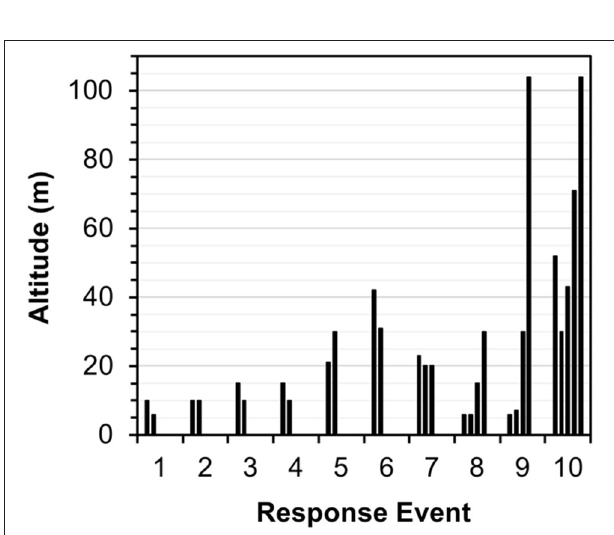
FIGURE 7 | Altitude of Antillean manatee response events to directional overhead UAS flight. Manatees directionally evaded the aircraft following multiple overhead movements despite ascents to 104m. The number of responses is listed from the first (initial) to the fifth individual